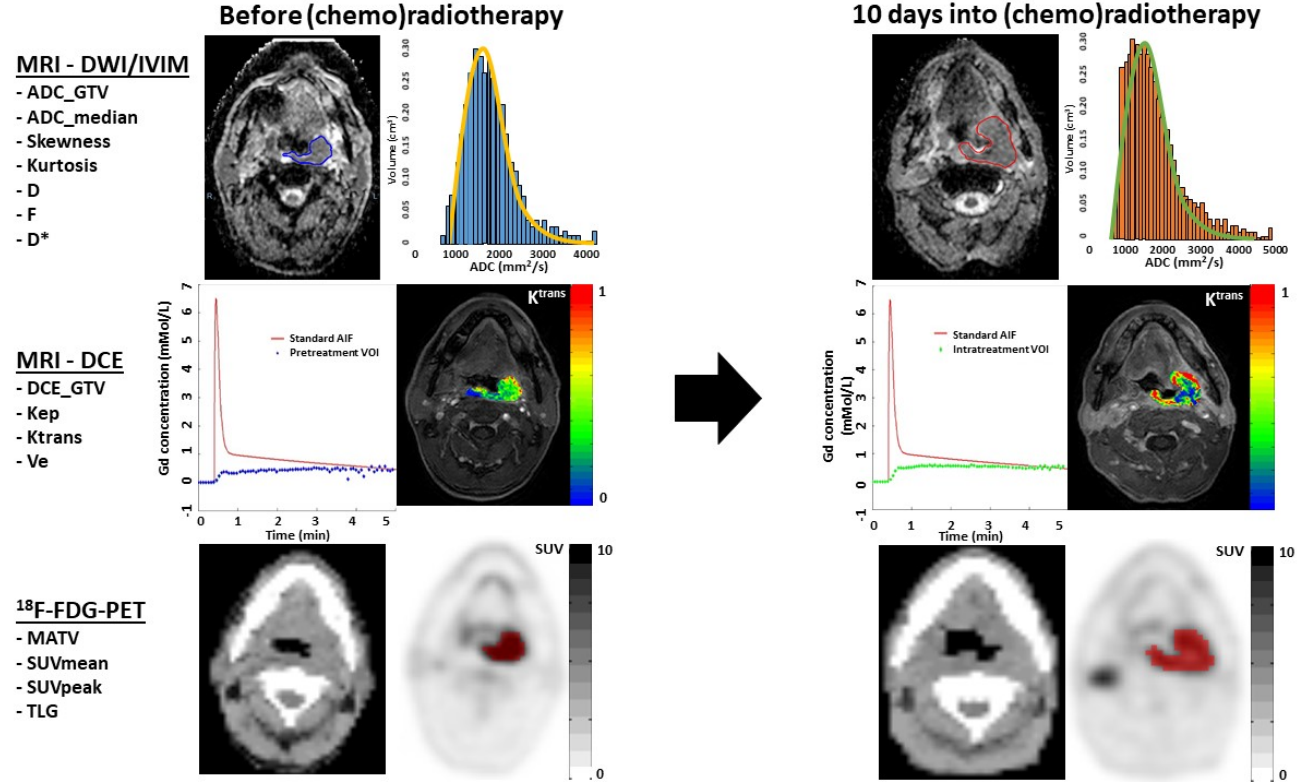
Figure 1. Overview of ADC, IVIM, DCE and FDG-PET imaging acquisition in a patient with left tonsillar carcinoma before and 10 days into (chemo)radiotherapy, and with whom locoregional failure occurred. The upper row shows the ADC map on which the tumor is delineated, in order to extract DWI and IVIM parameters. The subtle spatial mismatch was due to a slightly different angulation of the neck. The ADC histogram shows high pretreatment positive ADC_skewness (blue histogram), and an increase towards a higher intratreatment ADC_skewness (orange histogram). Furthermore, a high pretreatment ADC_kurtosis was associated with LRF (orange line). The middle row shows the population-based arterial input function (AIF) and a tumor concentration time curve. The images are DCE images at the 75 temporal phase, on which a colored functional map of the parameter K trans is superimposed in the delineated tumor. The color scale shows the range between 0 and 1 mMol/L. The 18 F-FDG-PET image in the lowest row shows the tumor delineation (red ROI) on the attenuation-corrected 18 F-FDG-PET image (black/white SUV scale ranges between 0 and 10), with a threshold of >50% SUV_peak and in anatomical correlation with a diagnostic CT scan.